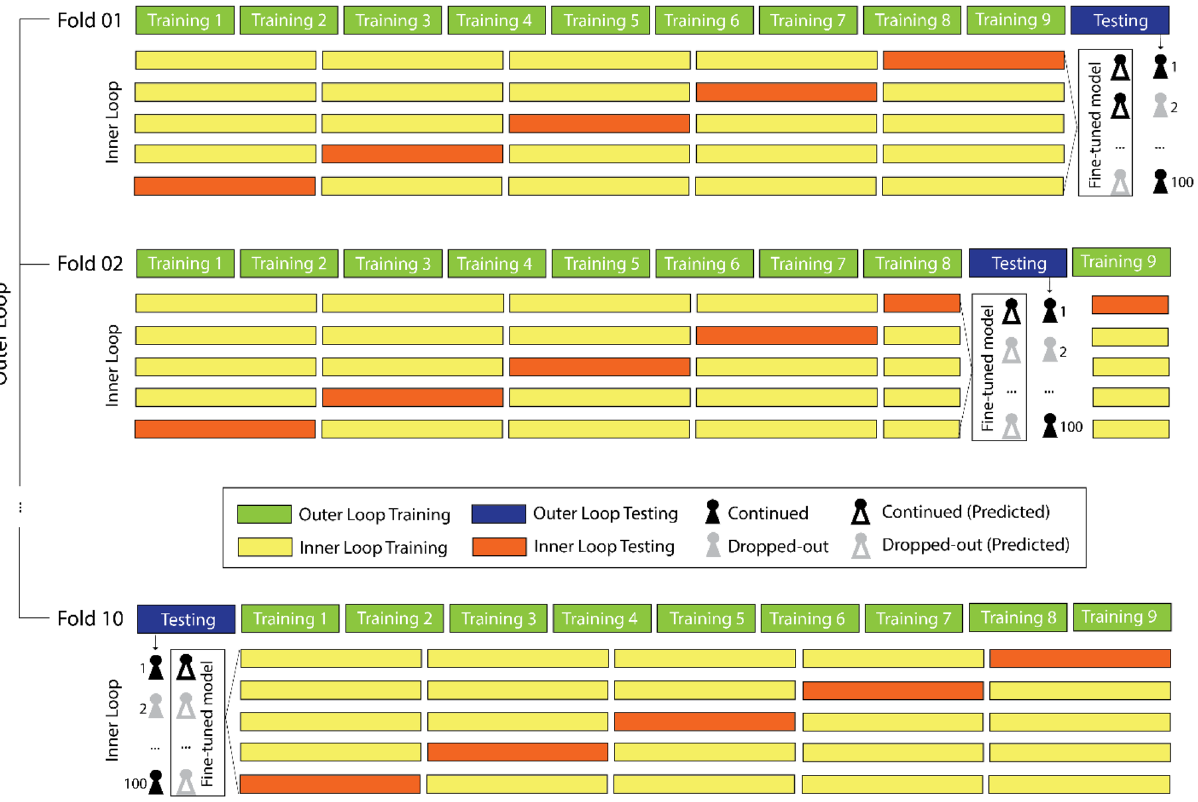
Figure 1. Schematic cross-validation procedure for out-of-sample predictions. The figure shows a tenfold cross- validation in the outer loop which is used to estimate the overall performance of the model by comparing the predicted outcomes for each student in the previously unseen test set with their actual outcomes. Within each of the 10 outer loops, a fivefold cross-validation in the inner loop is used to finetune model hyperparameters by evaluating different model